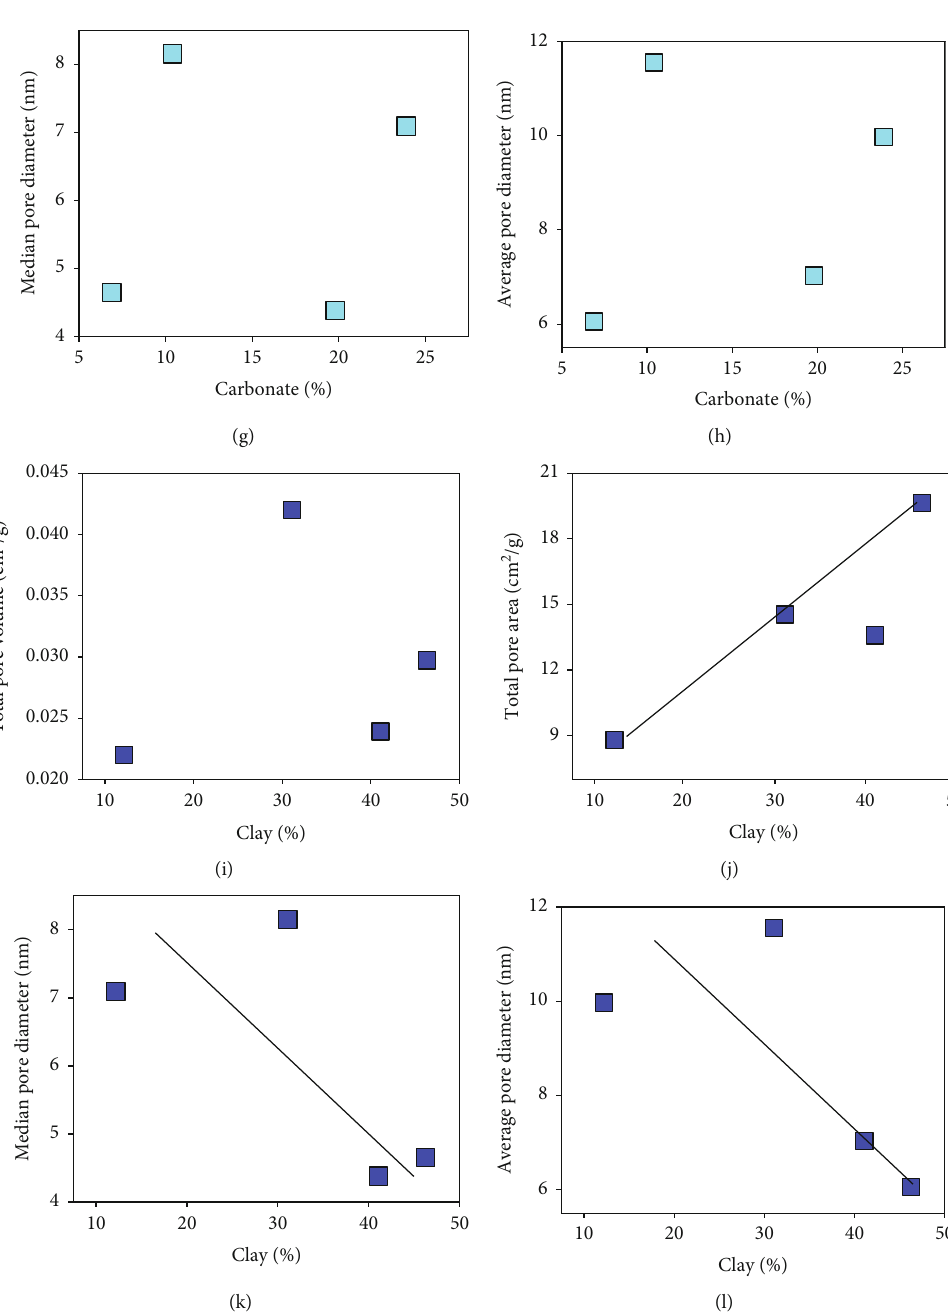
Figure 12: Relationship between MIP-derived total pore volume (a, e, and i), total pore area (b, f, and j), mediam pore diameter (c, g, and k), and average pore diameter (d, h, and l)" for better clari fi